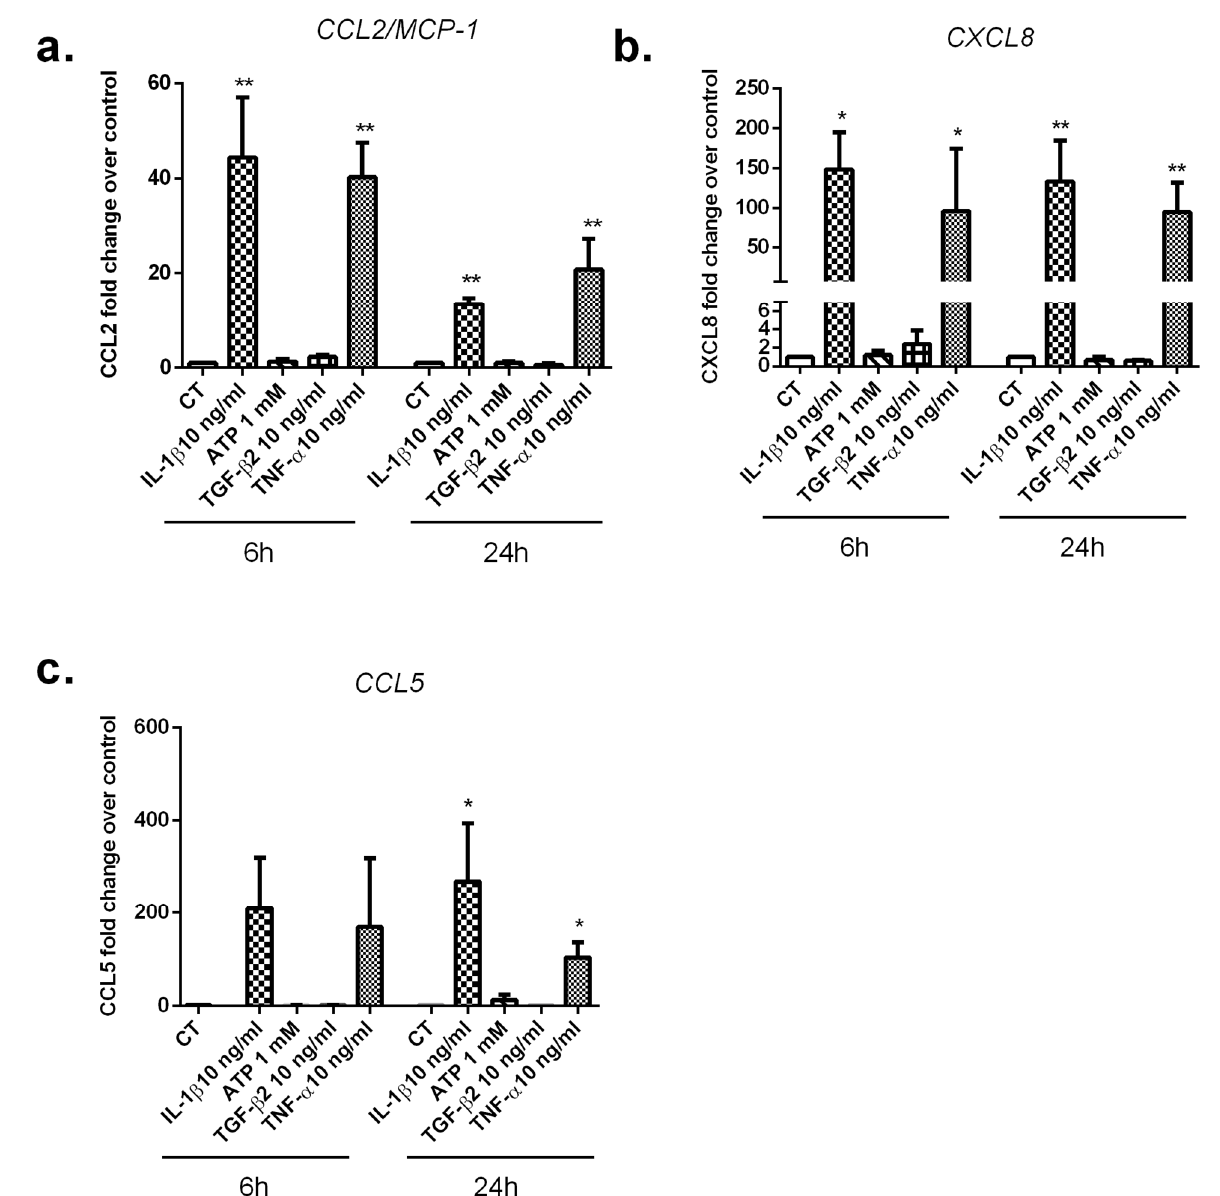
Figure 6. Regulated mRNA expression of proinflammatory chemokines in response to IL ‐ 1 β , TNF ‐ α , TGF ‐β 2, and ATP stimulations in SC. ( a ) Relative expression of CCL2, ( b ) CXCL8, and ( c ) CCL5 from SC stimulated by IL ‐ 1 β , TNF ‐α , TGF ‐β 2, and ATP for 6 h and 24 h, as assessed by qRT ‐ PCR. All experiments were done in triplicates. Results are expressed as mean ± SEM and presented as a normalized fold increase vs. control (CT). * p ‐ values ≤ 0.05 and ** p ‐ values ≤ 0.01 represent significant differences from controls by one ‐ way ANOVA followed by the Bonferroni’s test analysis.